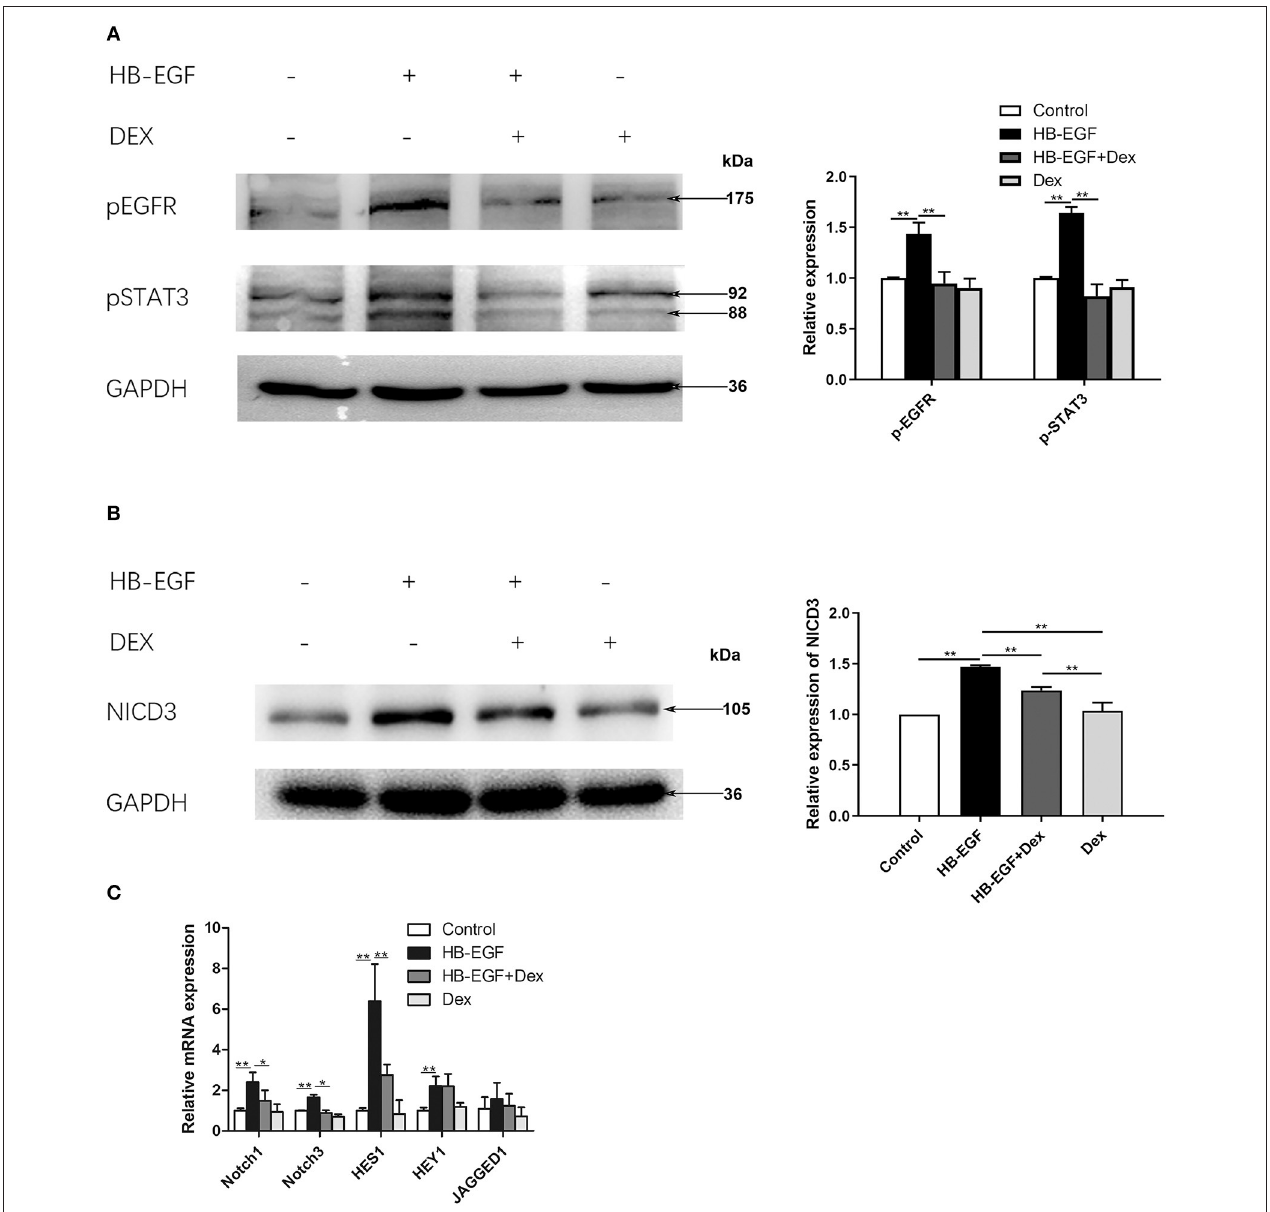
FIGURE 6 | Glucocorticoid treatment suppressed activation of EGFR, STAT3 and Notch3 in HB-EGF-treated podocytes in culture. (A) Immunoblotting showing that treatment of Dex prevented phosphorylation of EGFR (Tyr1068) and STAT3 (Tyr705) in HB-EGF treated podocyte (target bands are indicated by arrows) according to the samples treated for 3h. Quantifications of the blots are shown on the right. (B,C) Immunoblotting (B) and qPCR (C) showing Notch signaling was induced by HB-EGF, which was prevented by Dex. Quantification of the blots is shown on the right (B) . The data are expressed as the mean ± SD of three independent experiments (C) . * P < 0.05, ** P < 0.01 vs. mRNA levels on 0h at